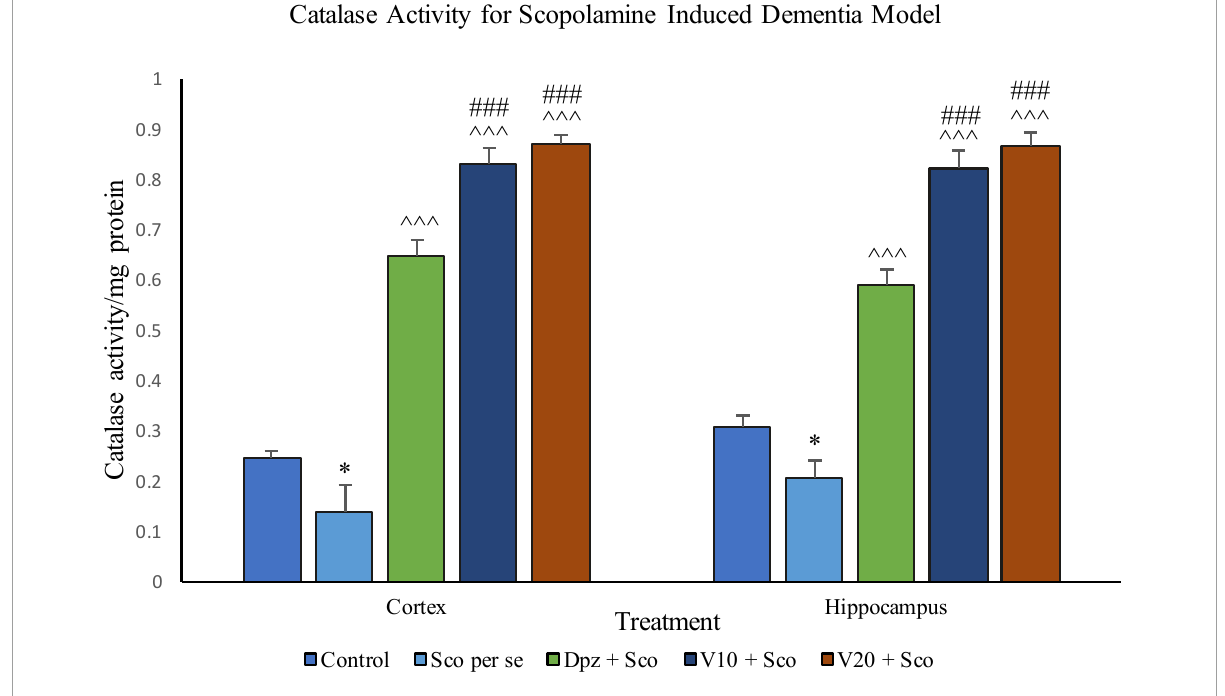
FIGURE20 Effect of vanillin and other treatments on catalase activity. Data are expressed as mean ± SEM. "*” denotes P < 0.05 with respect to the control group. “###” denotes P < 0.001 with respect to the standard treatment group, and “ ∧∧∧ ” denotes P < 0.001 with respect to the negative control (Sco per se )